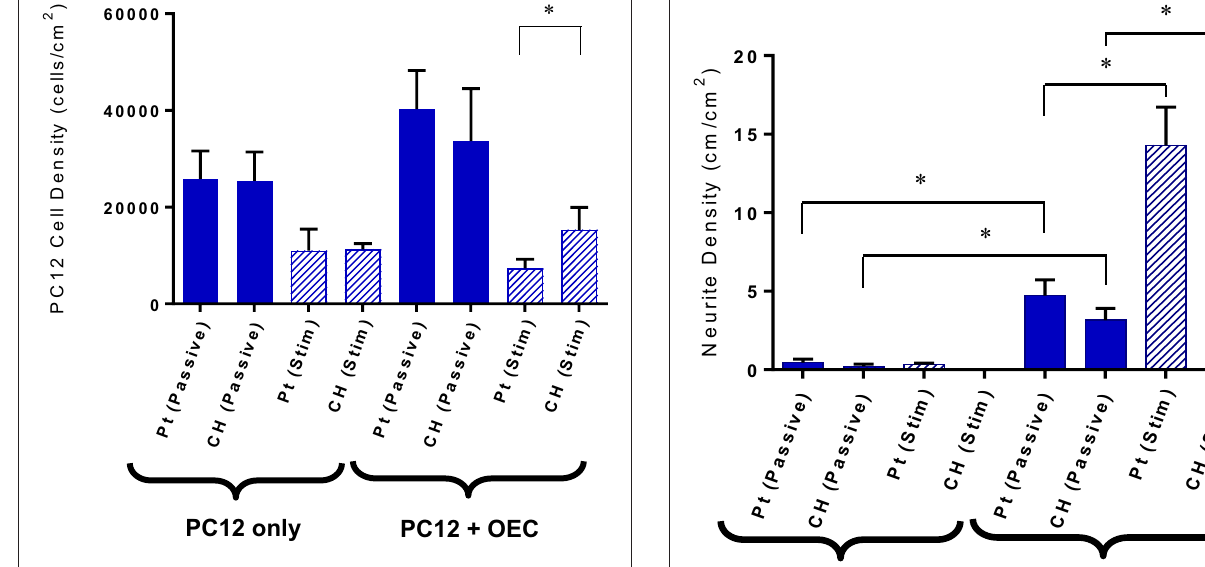
FIGURE 7 | Quantification of PC12 cell attachment when cultures with and without OECs on passive and electrically stimulated Pt and CH electrodes. Statistical analysis was in the form of Tukey one-way ANOVA, * p < 0.05. Error bars represent the standard error of the mean. FIGURE 8 | Quantification of neurite outgrowth density for PC12 cells